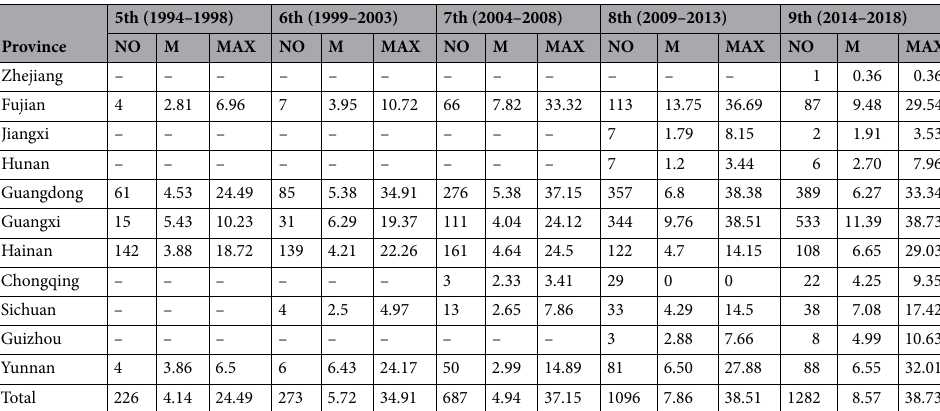
Table 2. Basic sample plot statistics (quantity, mean and maximum annual productivity) of eucalyptus plantations by province from the 5th to 9th NFIs. “NO.” refers to the amount of sample plots; “M” and “MAX” refer to mean and maximum annual productivity, respectively. (unit: m 3 hm −2 a −1 ). The same below.